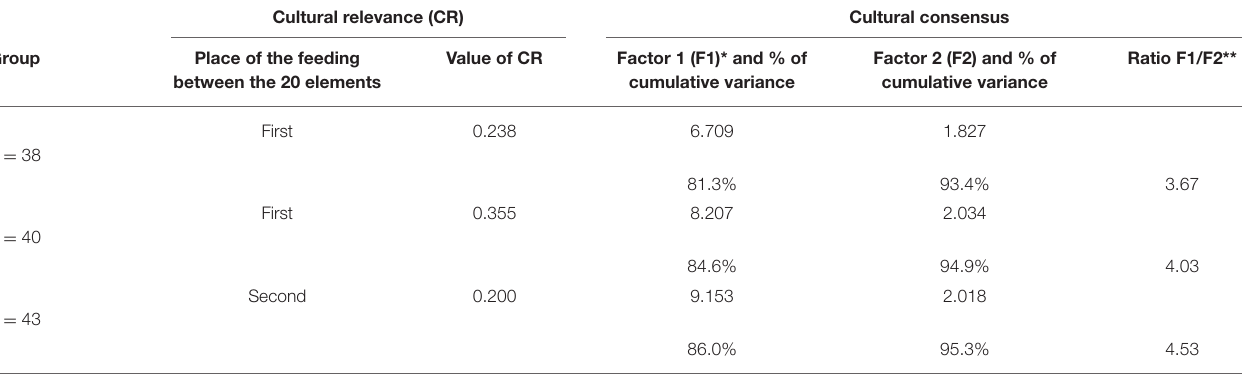
Deceive Education